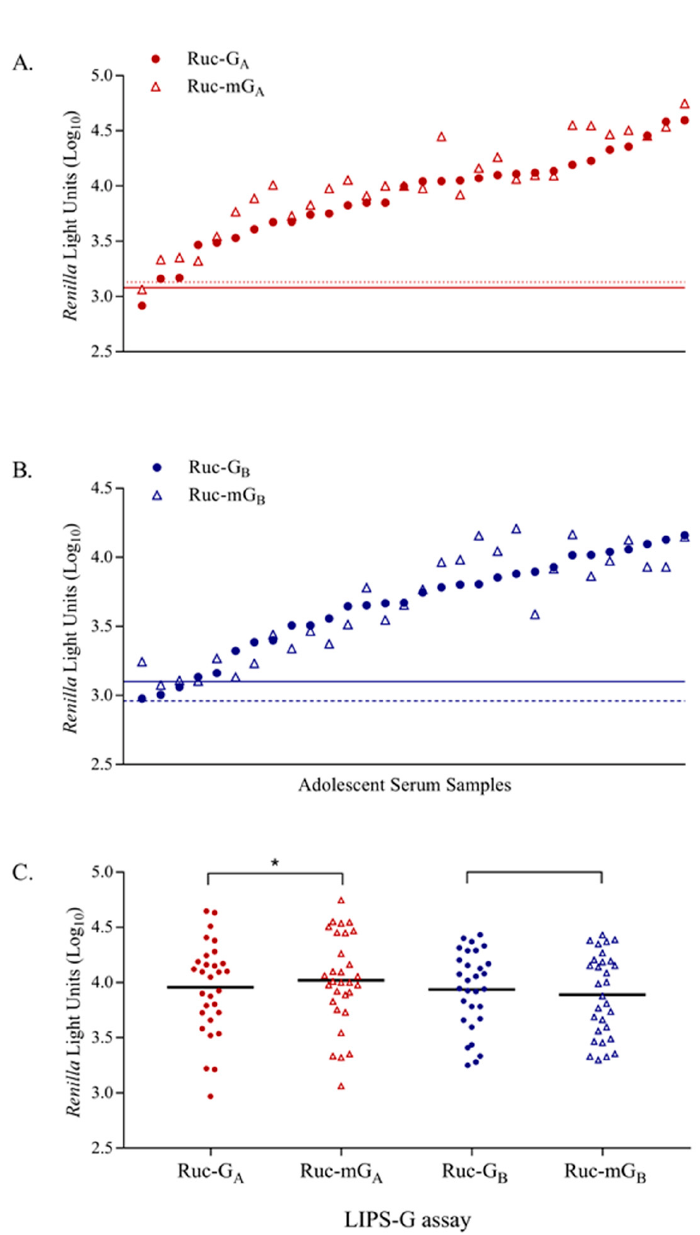
Figure 9. Reactivity of adolescent sera using native and mutated Ruc-G A and -G B antigens. Binding to native versus mutated antigen was compared using the adolescent serum panel. Data were normalized against rabbit anti-FLAG antibody for each antigen comparison; ( A ) Ruc-G A versus Ruc-mG A or ( B ) Ruc-G B versus Ruc-mG B . Immunoglobulin depleted serum (Ig ∆ ) was used as the negative control and cutoff values are shown as either solid (native) or dashed (mutated) horizontal red (Ruc-G A , Ruc-mG A ) or blue lines (Ruc-G B , Ruc-mG B ). Results are ranked from low to high based on testing against the Ruc-G A or Ruc-G B antigens and paired with the corresponding result for each subject against the Ruc-mG A or Ruc-mG B antigens, respectively. ( C ) Group RLU responses were plotted for all antigens tested. * indicates significant difference between groups ( p = 0.0013).